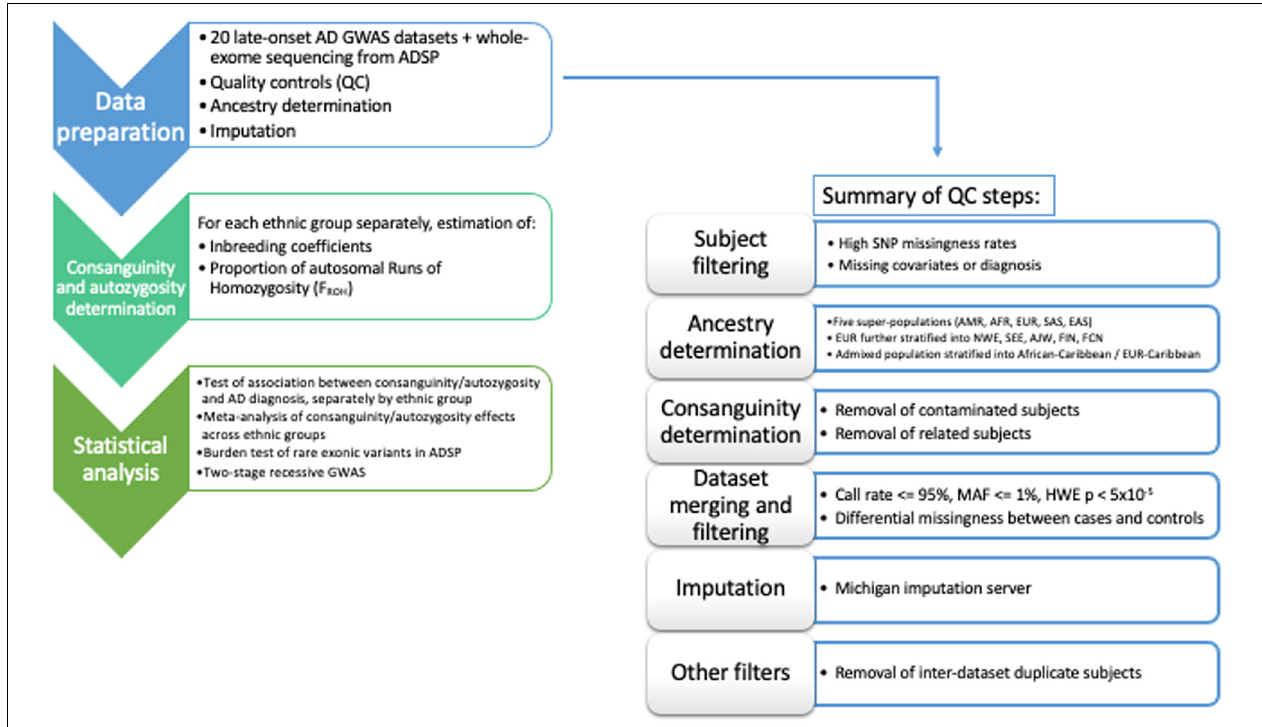
FIGURE 1 | Flow-chart of the workflow adopted in the data QC/harmonization/ancestry-determination processing of the full